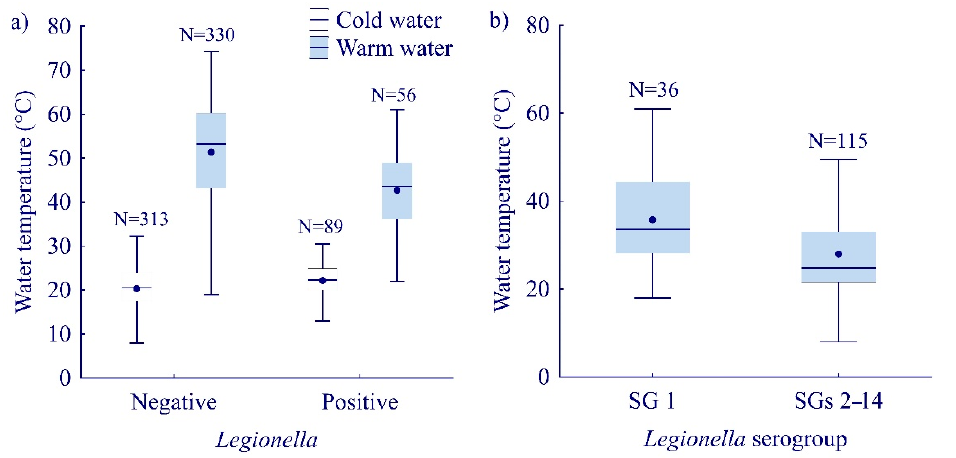
Figure 4. Water temperature in relation to: ( a ) Legionella presence; ( b ) Legionella strains (serogroups 1 vs. 2–14). Boxplots show median (line), mean (point), quartiles (boxes), non-outlier range (whisk- ers).